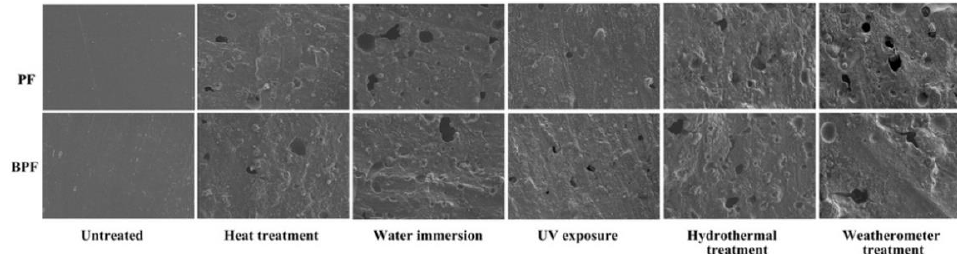
Figure 3. SEM images of BPF and PF resin films under five aging conditions for 960 h (×500).